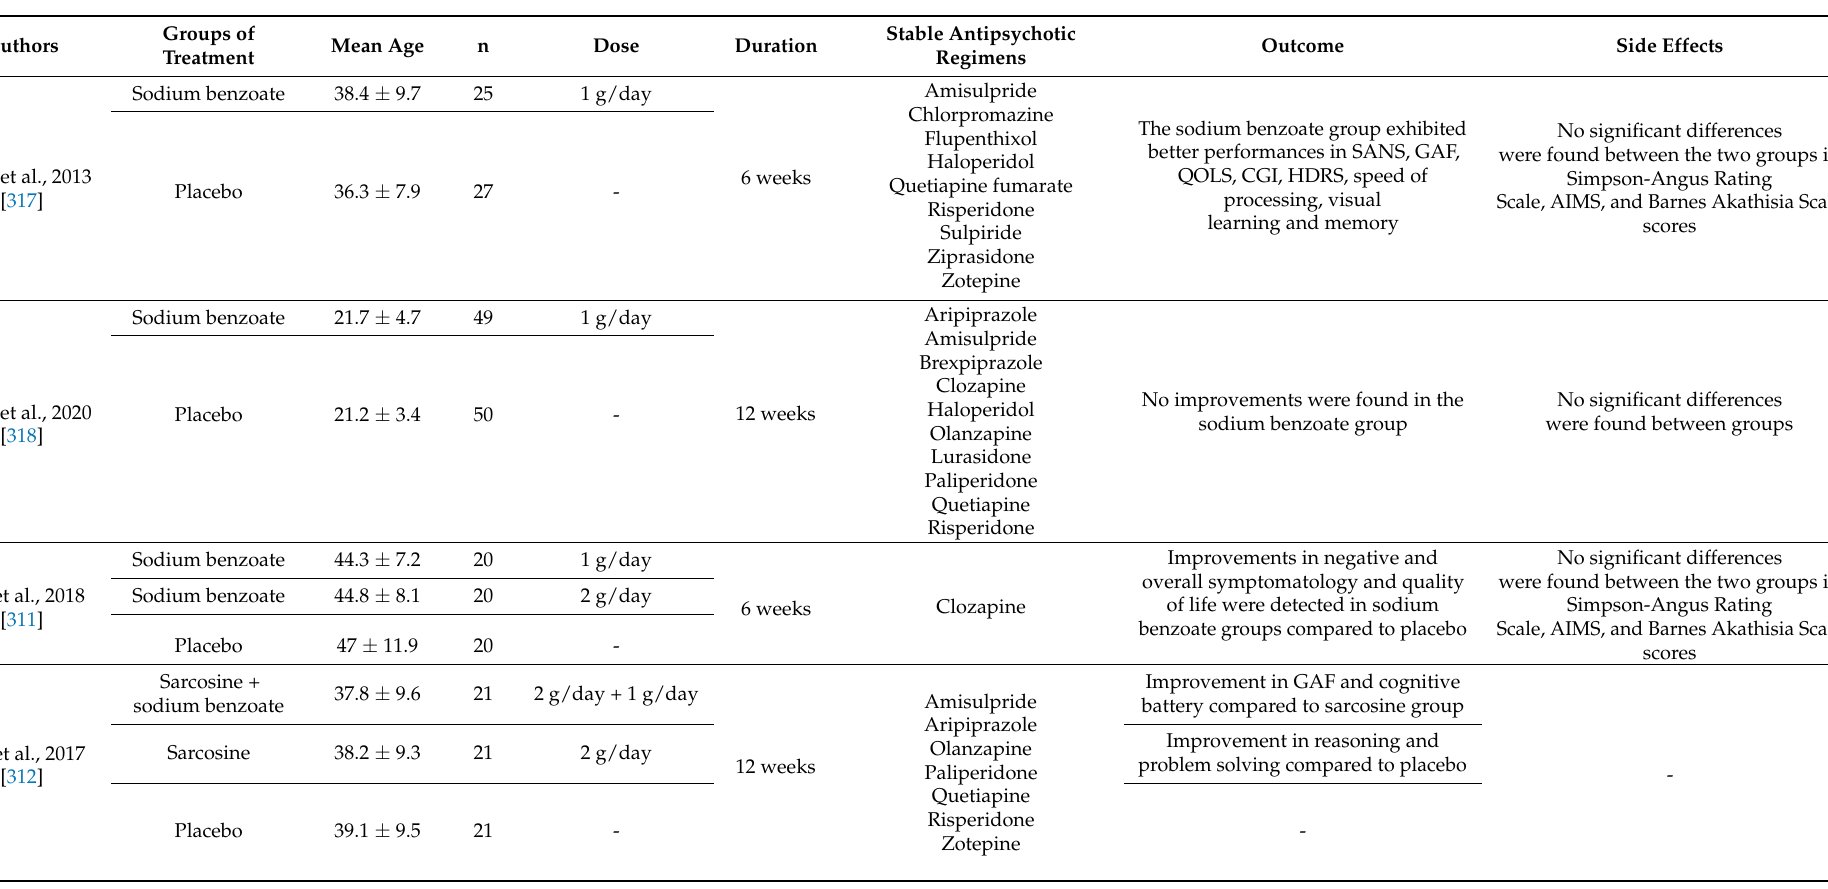
Table 2. Randomized clinical trials investigating the efficacy of sodium benzoate as a DAO-inhibitory agent in treating chronic schizophrenia and early